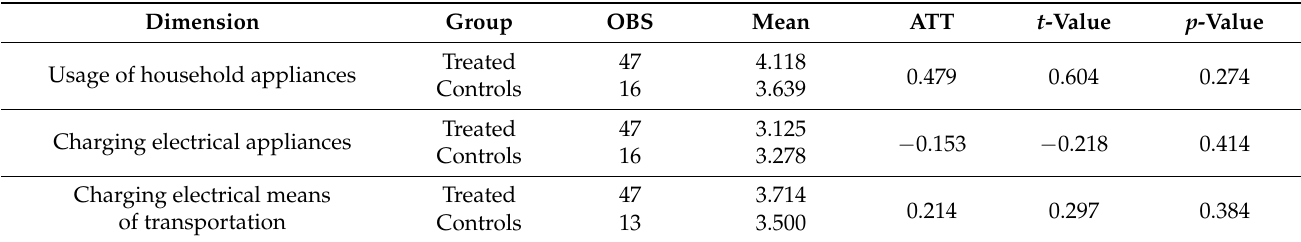
Table 11. Demand flexibility comparisons of Solar-consellers (treated) versus Solar-sellers controls) (source: authors’ own calculations).